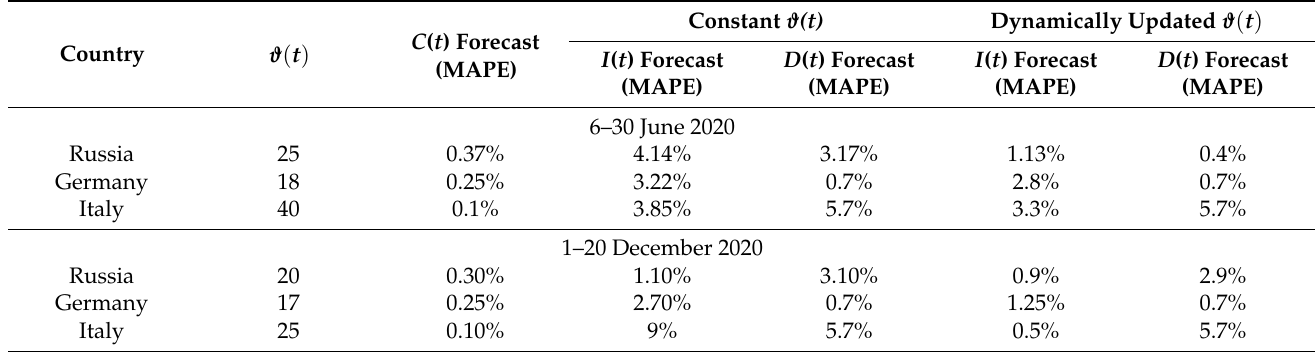
Table 2. Forecast results for the constant and dynamically updated ϑ ( t ) .